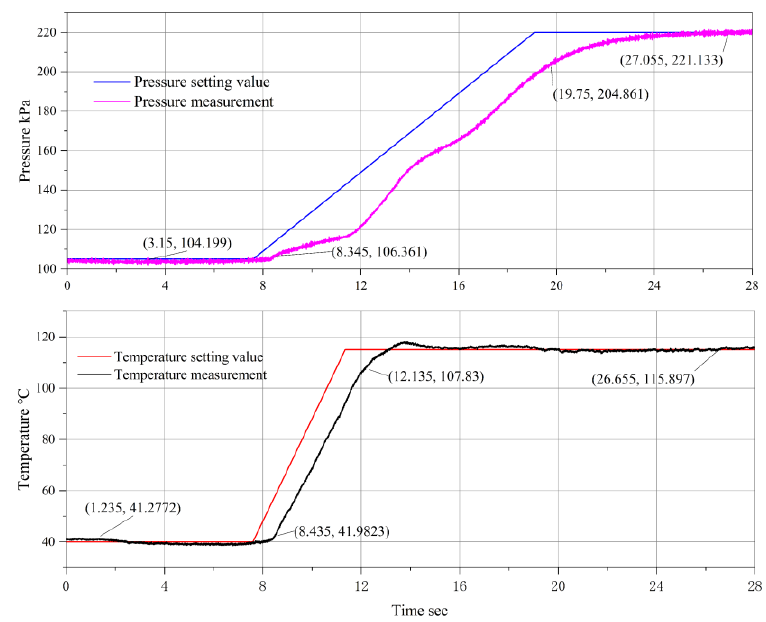
Figure 12. Fan bleed air simulation under the rise rates of 10 kPa/s and 20 ℃ /s.